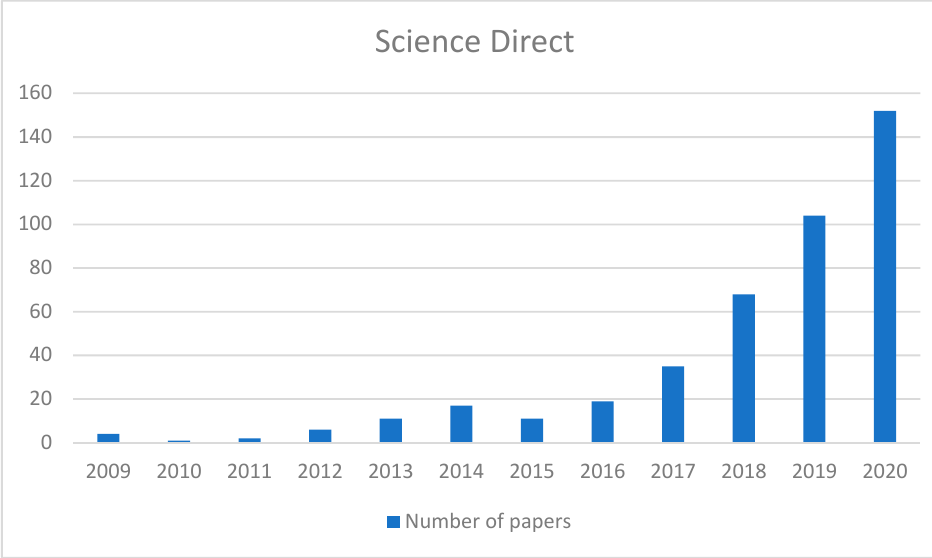
Figure 2. Statistics of the number of HEML papers by Science Direct over the years.